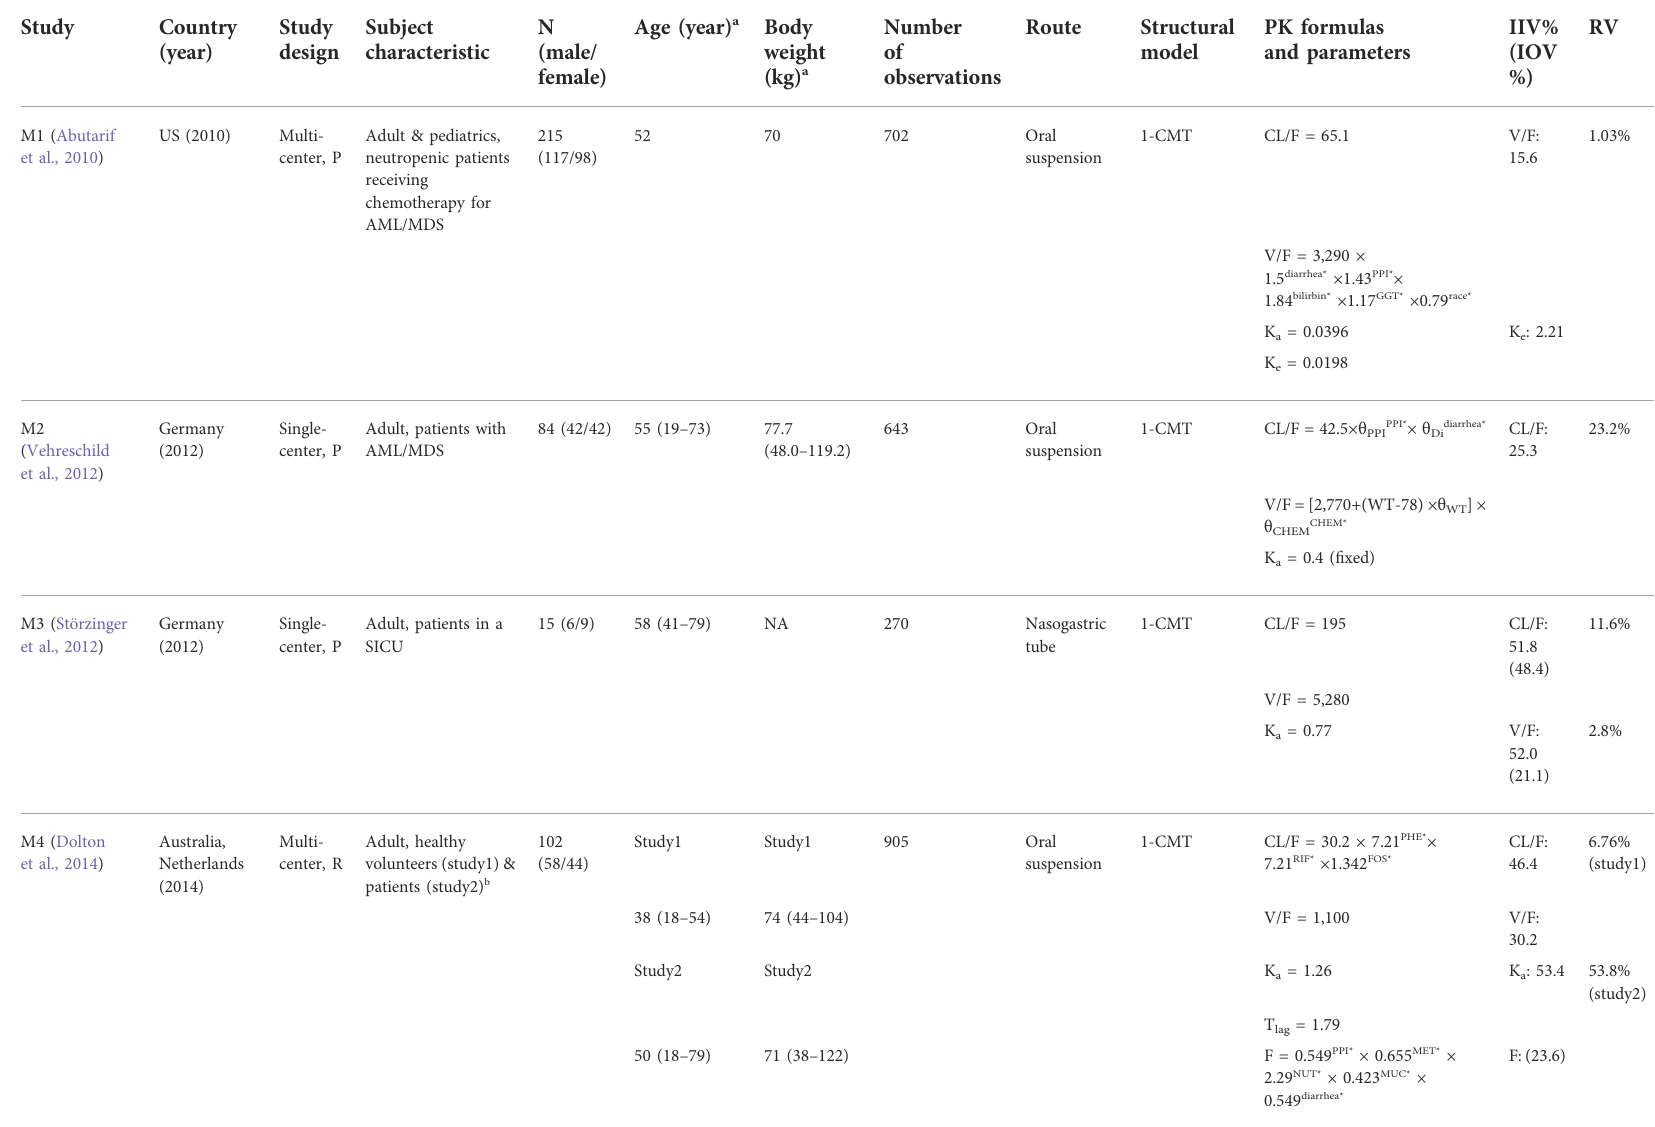
TABLE 1 Summary of published population pharmacokinetic studies of